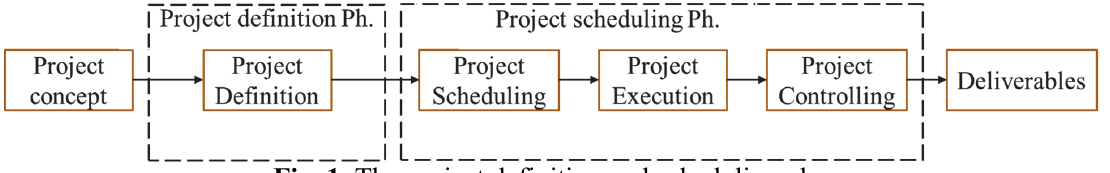
Fig. 1. The project definition and scheduling